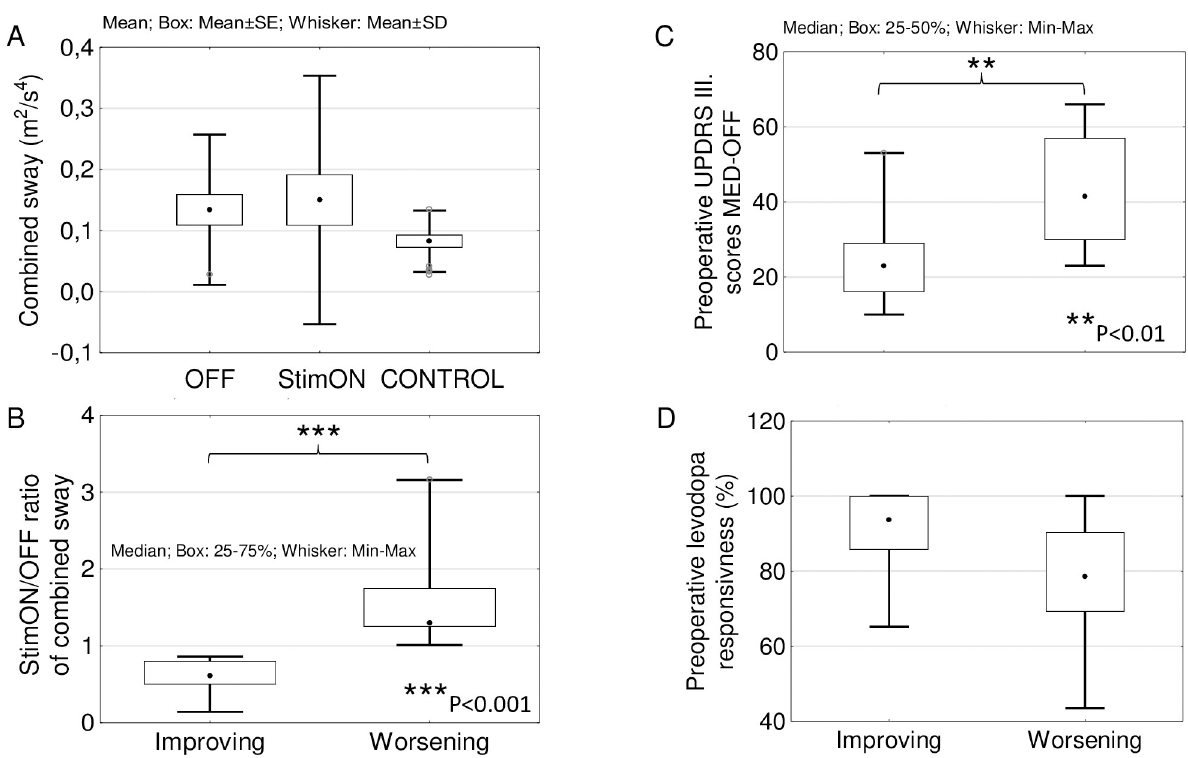
Fig 3. Correspondence between combined sway, symptom severity and levodopa responsiveness. (A) Combined sway on the group level did not differ in the StimON and OFF condition in the patient group and the controls. (B) Stimulation-induced improving and worsening balance subgroups was created based on the StimON/OFF ratio of the combined sway values. (C) UPDRS III scores in medication OFF state was significantly higher representing more severe motor symptoms in the worsening compared to the improving subgroup. (D) Levodopa responsiveness did not distinguish the two subgroups; however, it was higher than 60% in the improving subgroup and higher than 40% in the worsening subgroup.